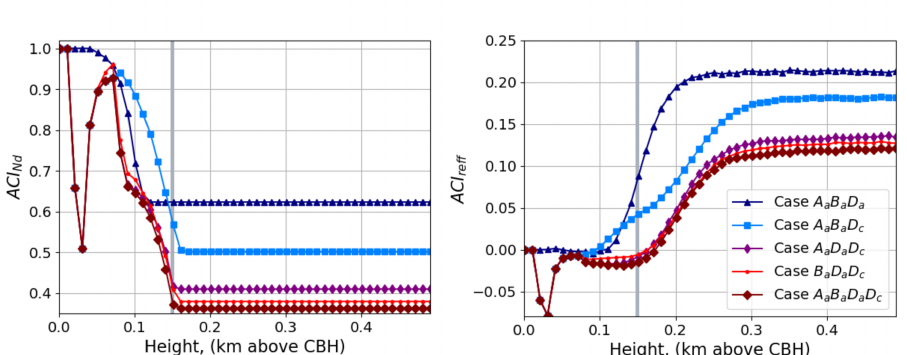
Figure 11. ACI Nd , ACI ref f for different mixtures of three and four aerosol types according to the